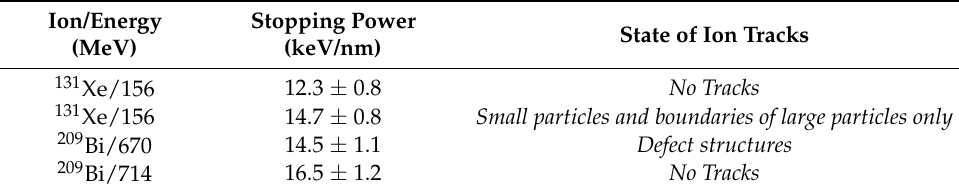
Table 1. Summary of stopping powers where tracks are not formed, not amorphous, or only observed in special